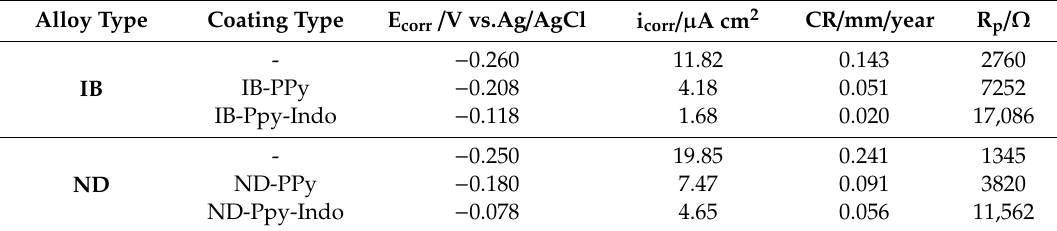
Table 3. Values of corrosion parameters resulted from polarization curves in SBF for bare NiCr alloys, PPy and PPy-Indo